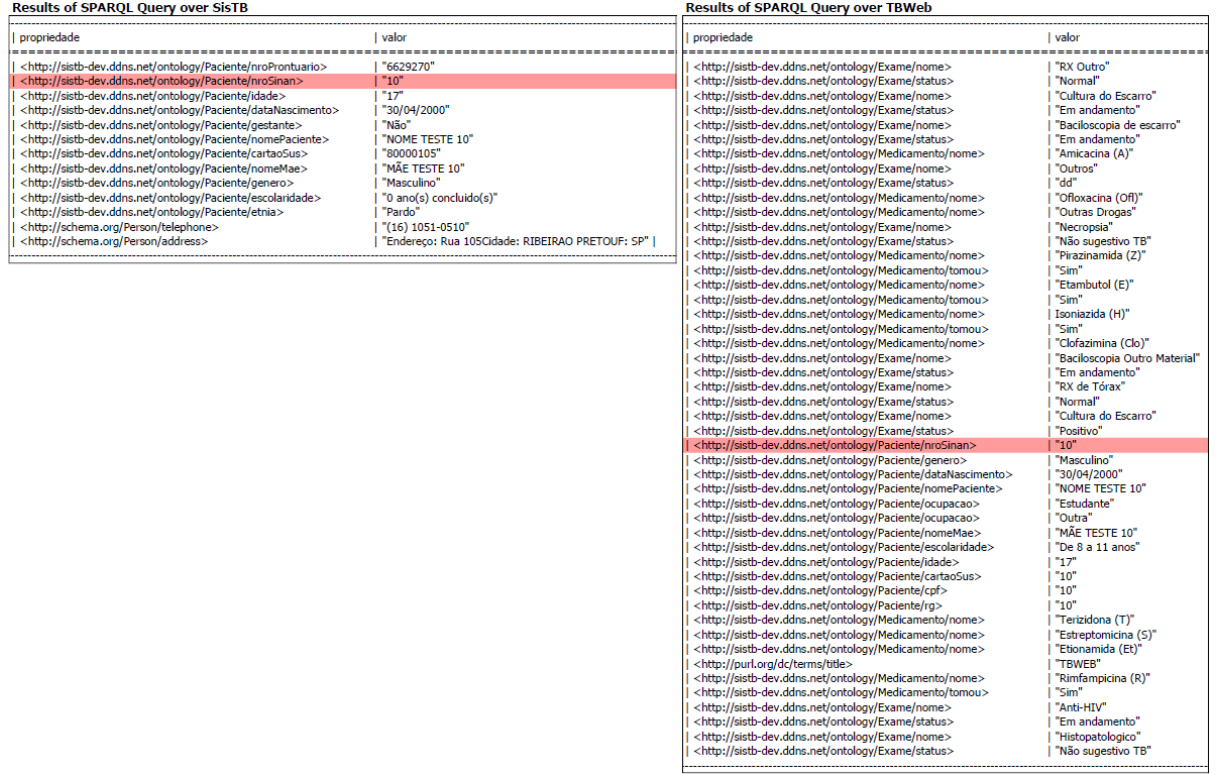
Figure 7. Results of a SPARQL query simultaneously on SISTB and Notification and Monitoring System for Cases of Tuberculosis in the State of São Paulo (TBWEB) for a specific patient with